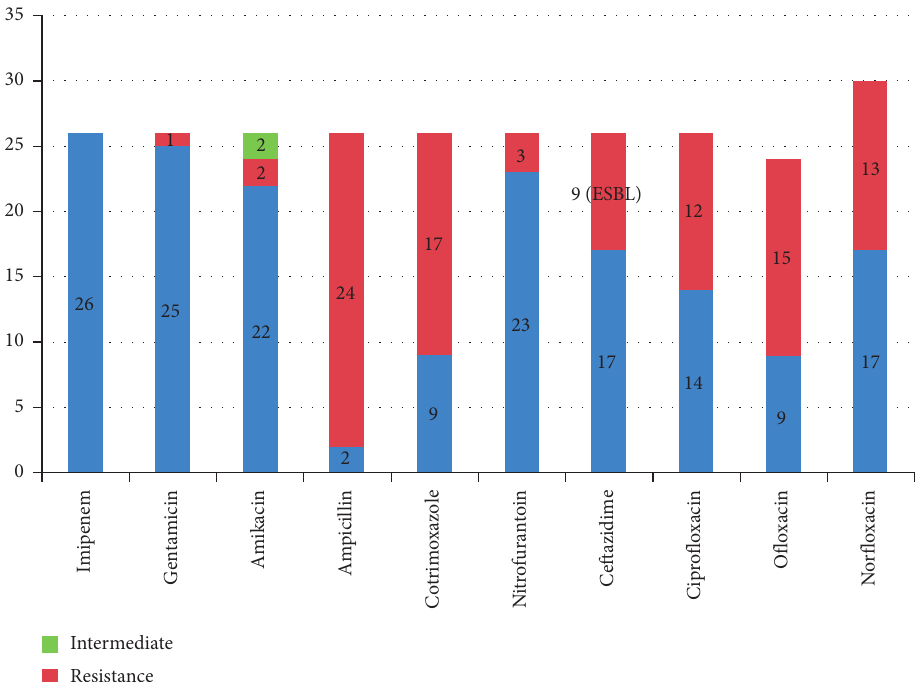
Figure 2: Nidus-antimicrobial susceptibility pattern of Gram-negative bacteria.